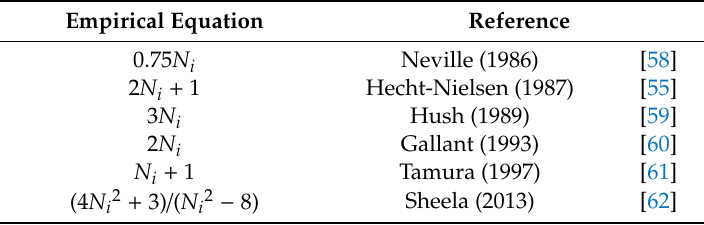
Table 2. Empirical equations for the number of hidden neurons ( N h ).